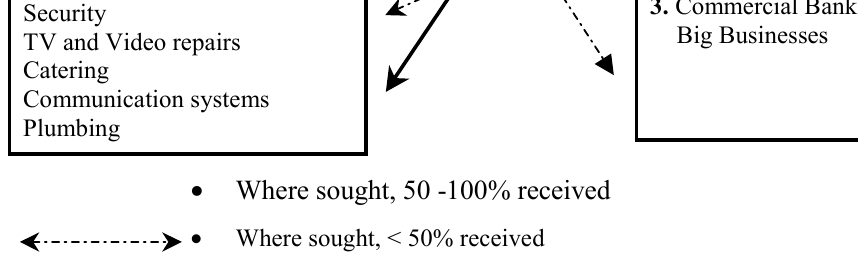
Figure 2: Accessibility of small business support